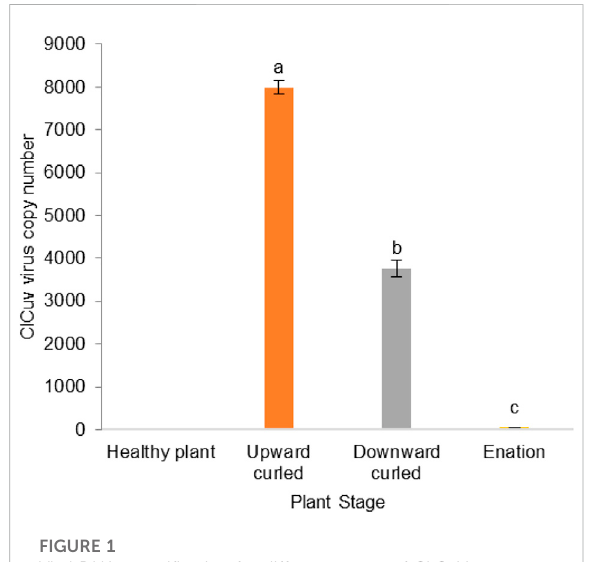
FIGURE 1 Viral DNA quanti fi cation for different stages of CLCuV infected cotton